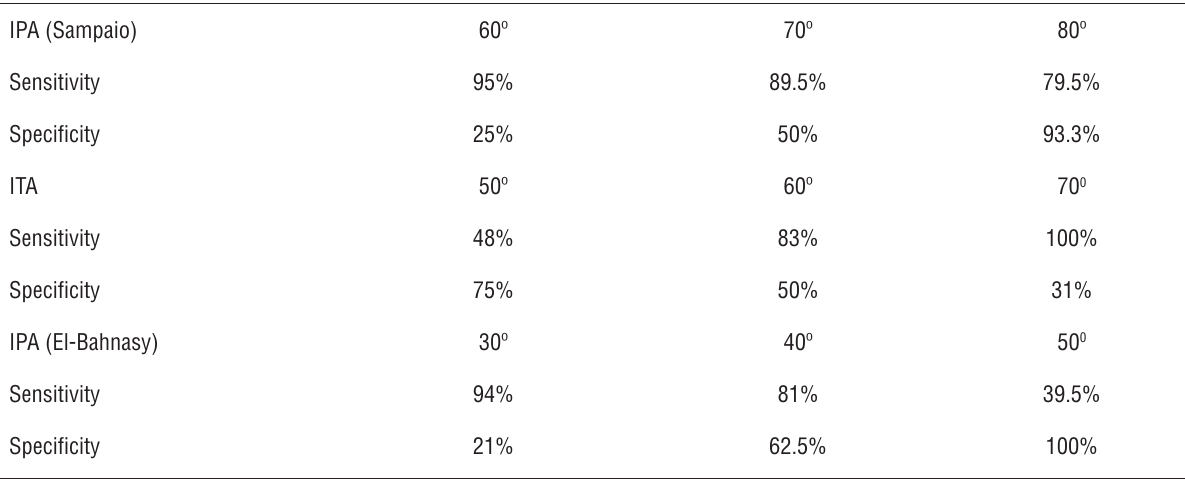
Table 4 - Sensitivity and specificity rates of IPAs (Sampaio and El- Bahnasy) and ITA when different angles were taken as cut off points.